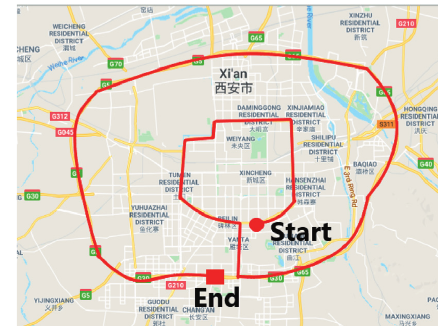
Figure 2: Data collection route.